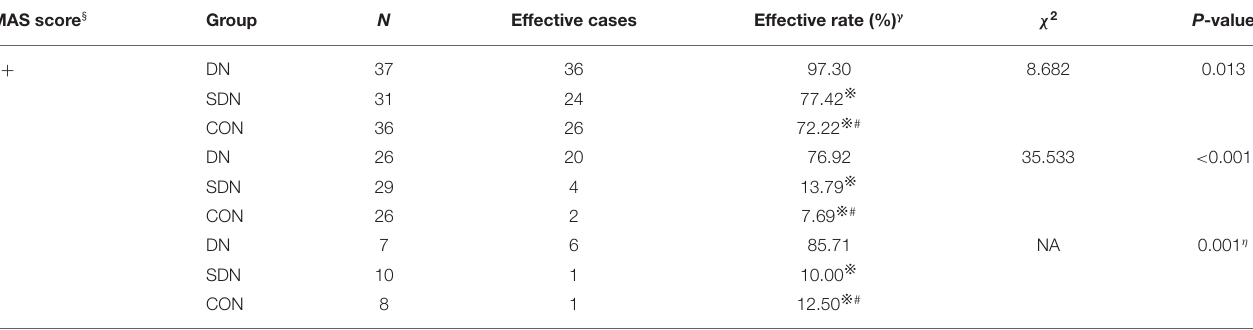
TABLE 4 | Immediate effective rate of thumb spasticity relief in patients with different degree of spasticity.